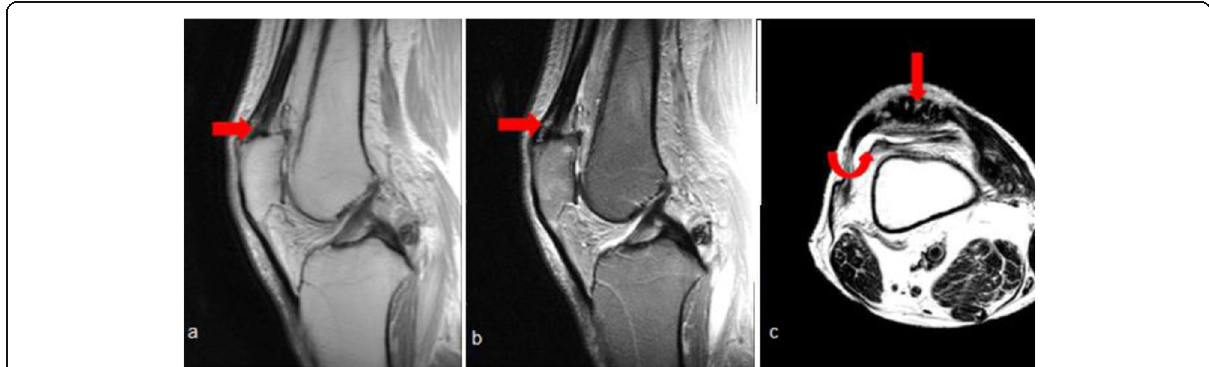
Fig. 12 a – c MRI images for quadriceps tendinopathy. a Sagittal PD weighted and b PD fat suppression demonstrated high signal intensity within the quadriceps tendon at the patellar attachment. c Axial T2-weighted image demonstrated a high signal intensity within the quadriceps tendon (red arrows) as well as a minimal amount of joint effusion (curved red